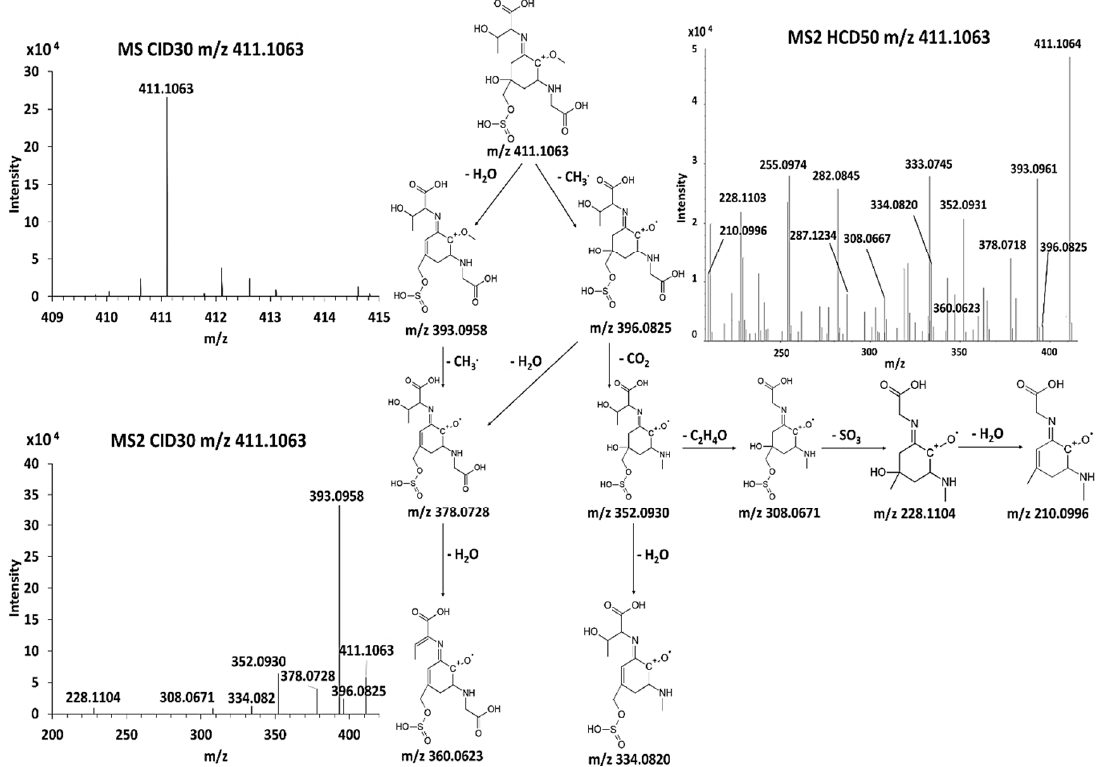
Figure 6. Structural elucidation of the novel MAAs m / z 411.1063 based on MS 3 /MS 4 data collection.